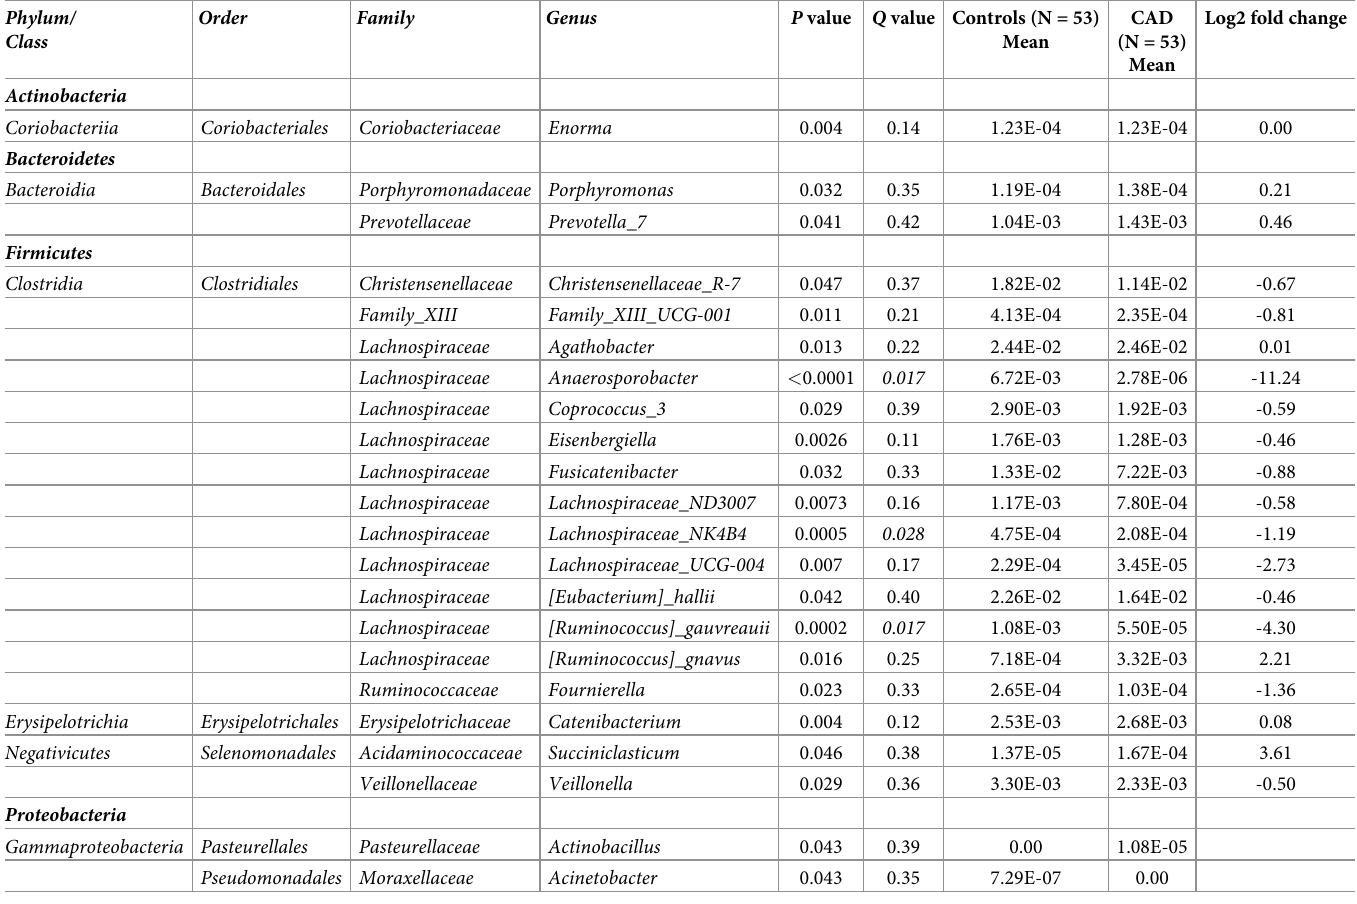
Table 2. Differentially abundant taxa between control and CAD patient samples at genus level. Phylum/